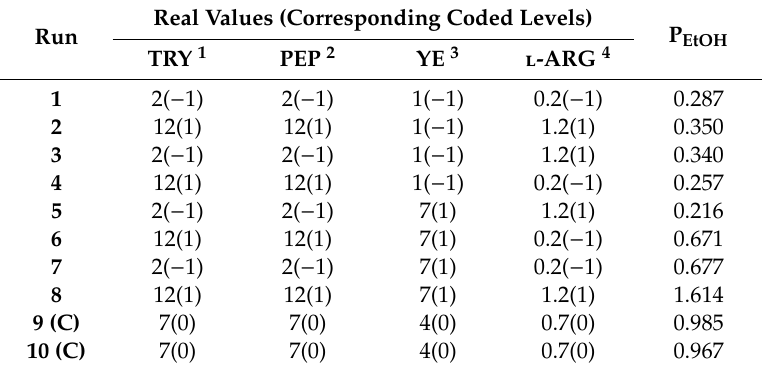
Table 6. Fractional factorial design matrix with real and coded values and ethanol production after 144 h of syngas fermentation by Clostridium carboxidivorans —P EtOH (g / L).